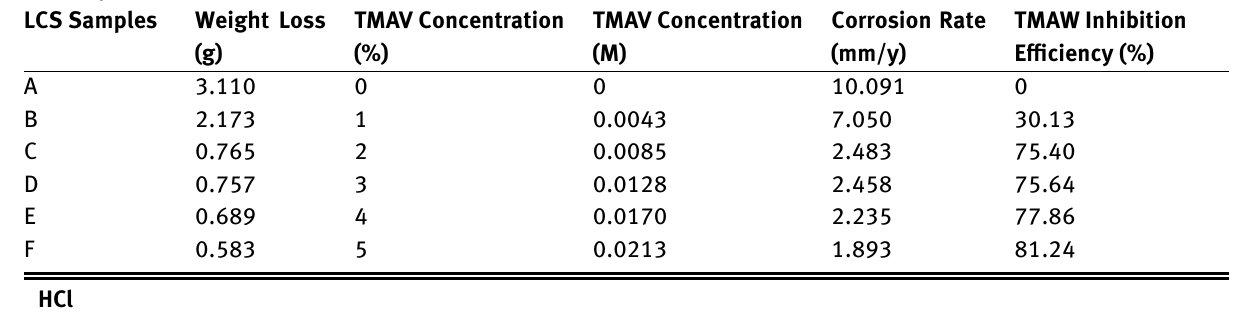
Table 4: Results obtained from weight loss measurement at 480 h of exposure H 2 SO 4